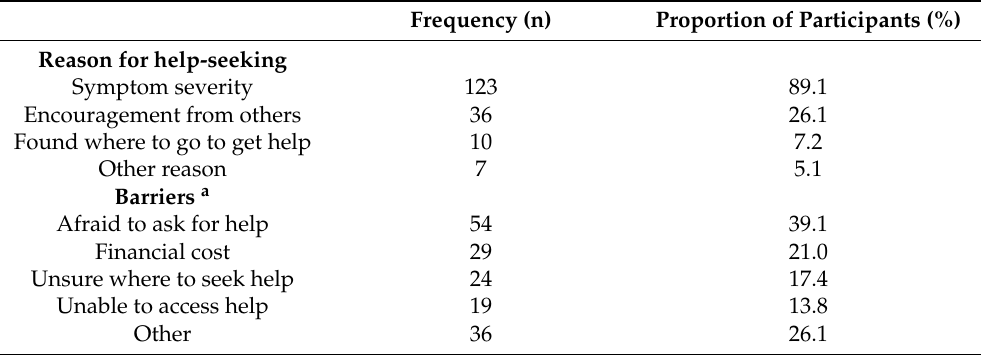
Table 2. Participant reported reasons for and barriers to seeking help for